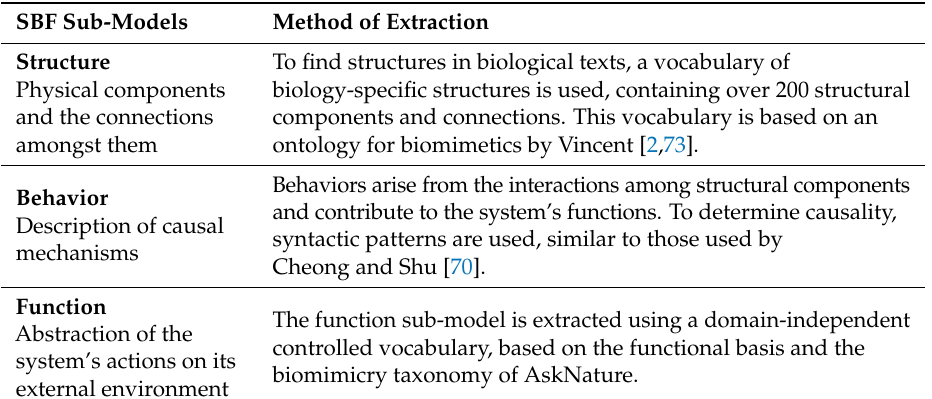
Table 4. The Structure–Behavior–Function (SBF) sub-models are used as indices when searching a repository of processed and annotated biological research papers. They are independently extracted from the papers and interlinked. Adapted from Goel et al. [71], Spiliopoulou et al. [72], and Rugaber et al. [21].